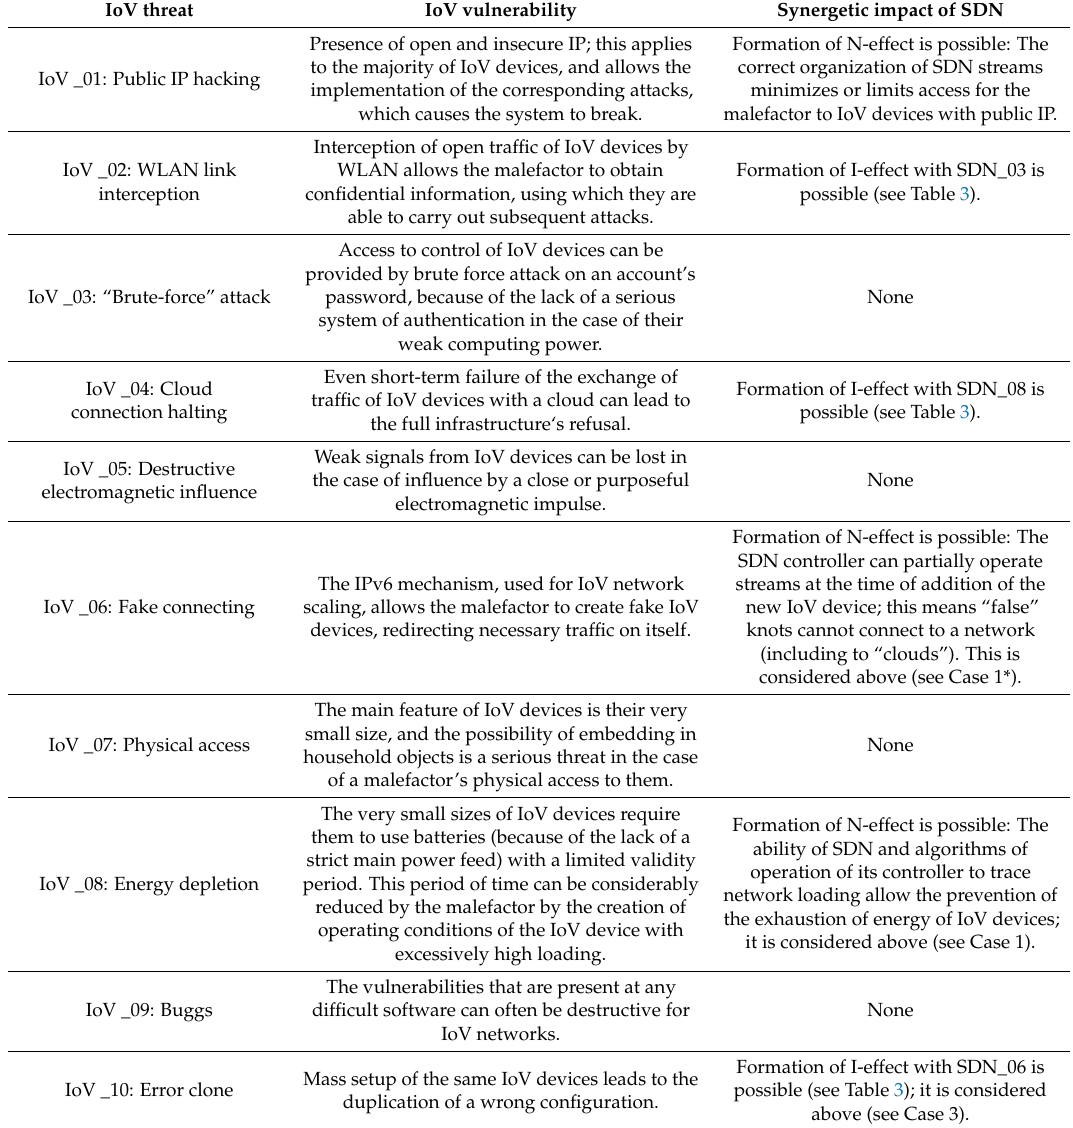
Table 4. Results of synergetic impact of SDN on vulnerabilities of